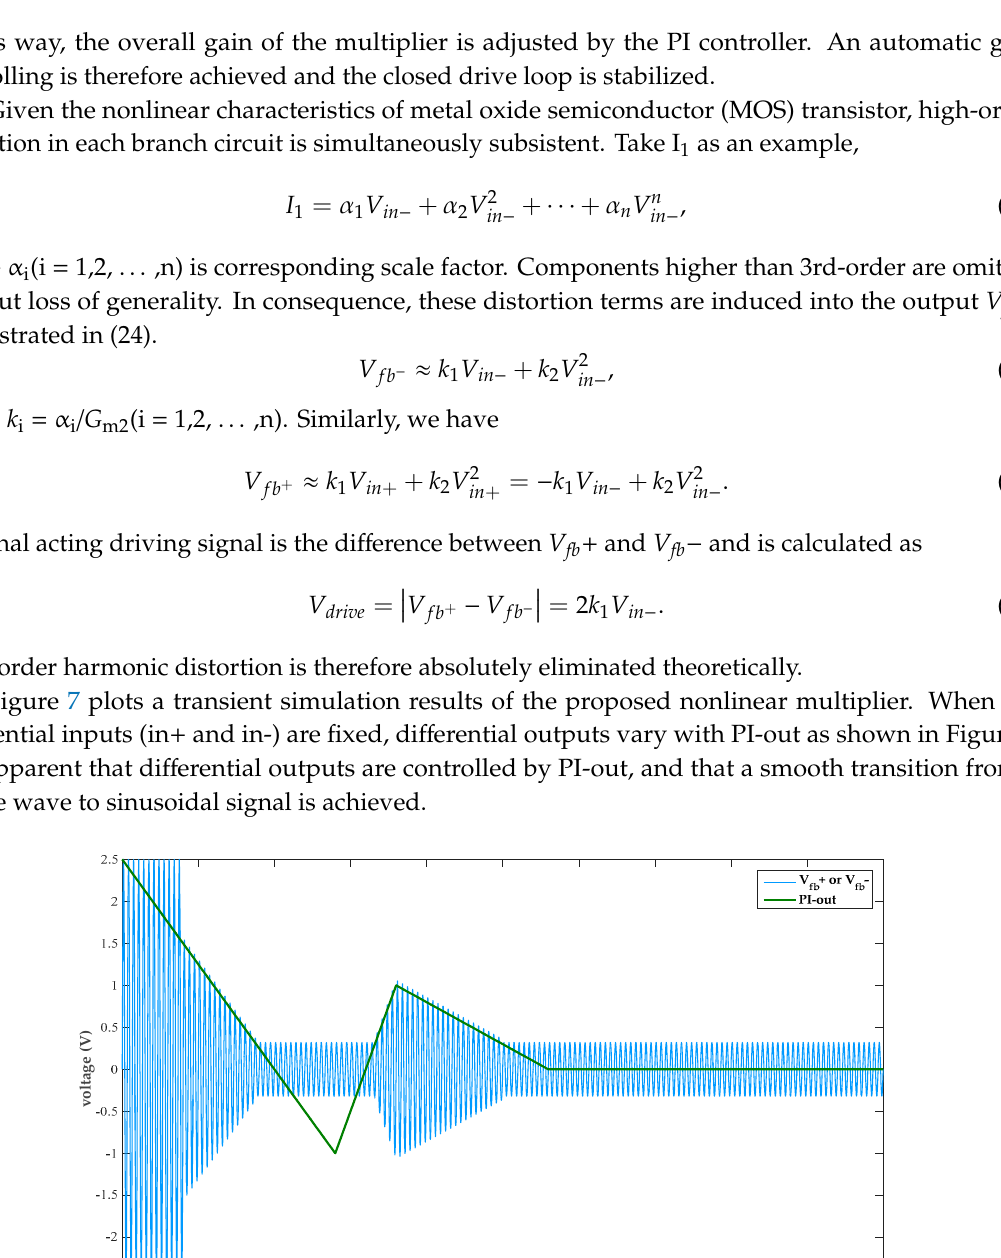
Table 1. Linearity simulation results of the proposed nonlinear multiplier.